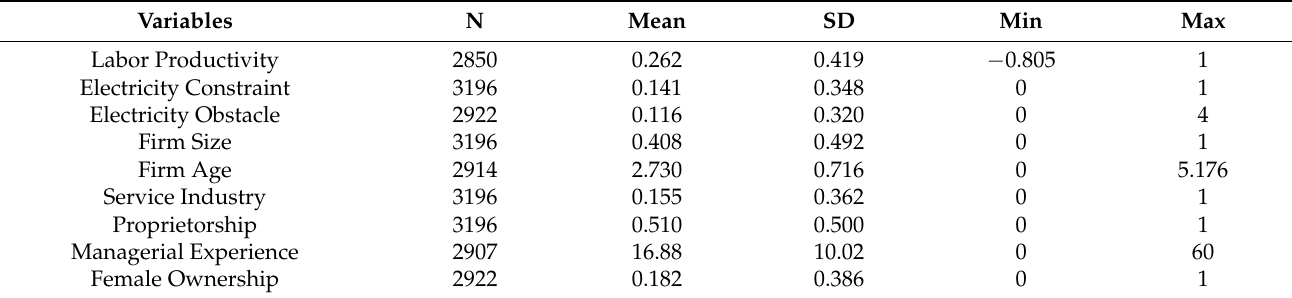
Table 2. Summary of descriptive